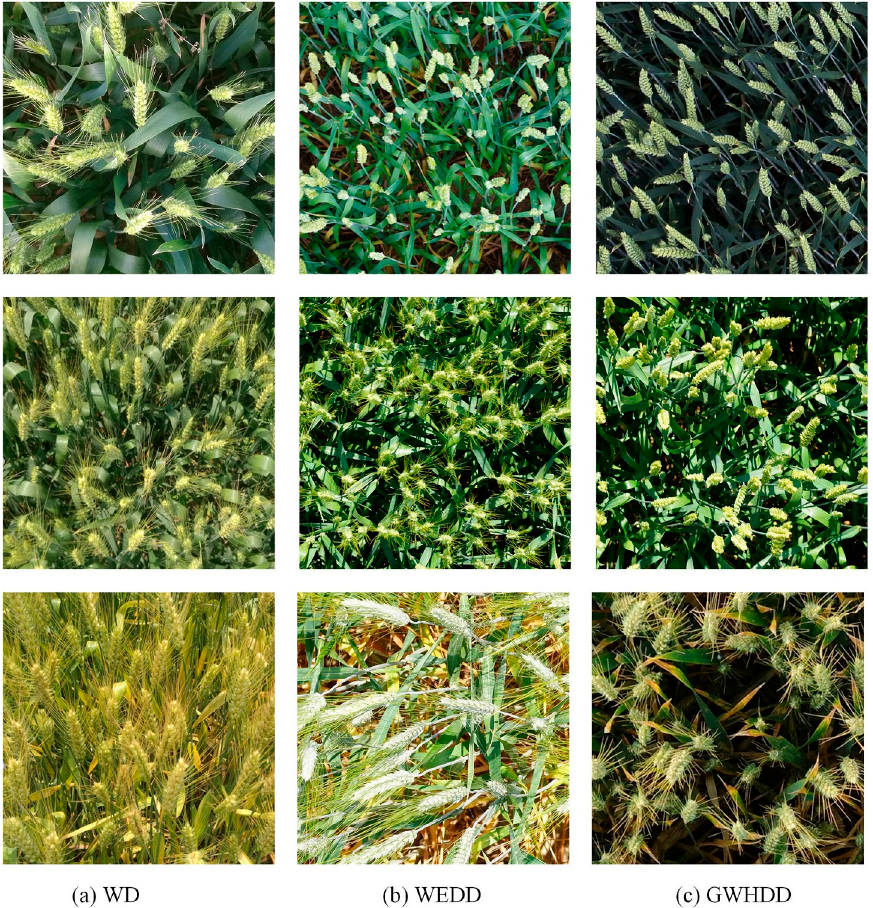
Figure 1. Samples of the wheat ears from different datasets.